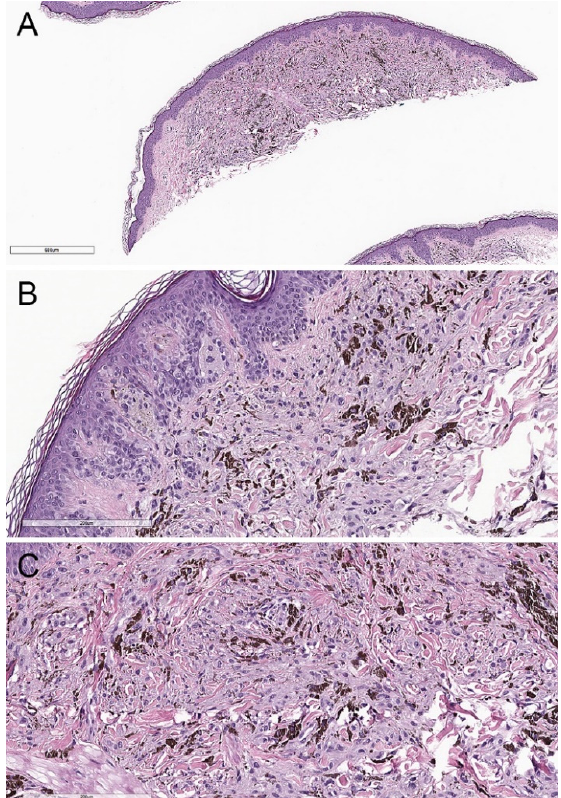
Figure 5. Atypical deep penetrating nevus. ( A ) The atypical architectural and cytological features exceed those seen in conventional deep penetrating nevi (hematoxylin and eosin, 40×). ( B ) The junctional component is predominantly nested and epithelioid with occasional pagetoid upward migration of atypical single cells (hematoxylin and eosin, 200×). ( C ) The dermal melanocytes are spindled and admixed with melanophages. Scattered cells show severe cytologic atypia (hematoxylin and eosin, 200×). In this case, findings on fluorescence in situ hybridization with probes for RREB1 , CCND1 , MYC , and CDKN2A were within normal limits.